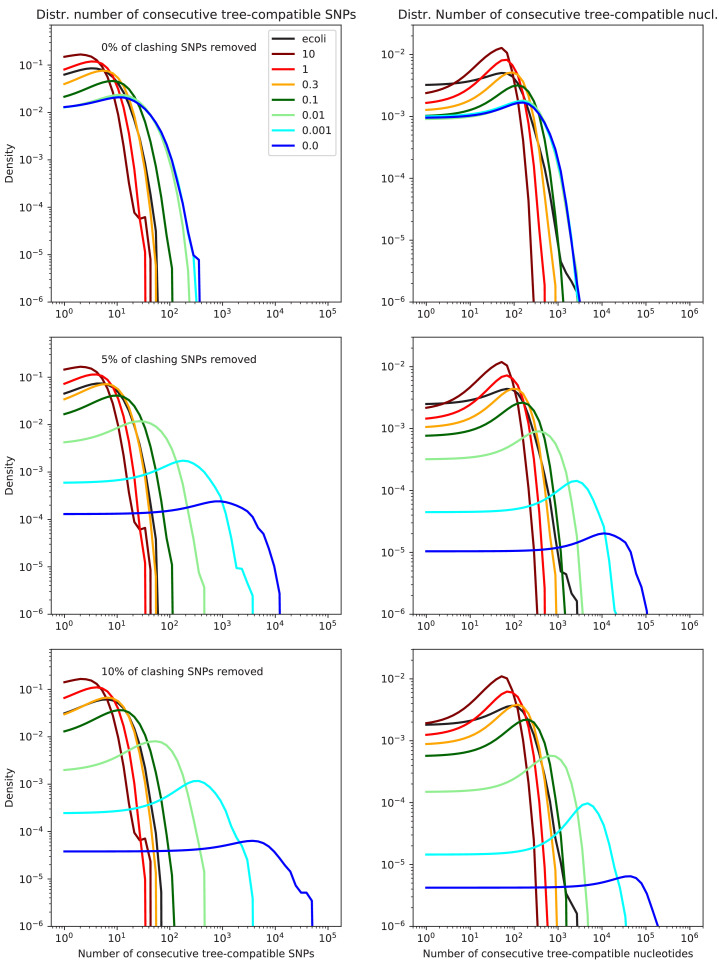
Lengths of tree-compatible segments for the data from the simulations.Probability distributions of the length of tree-compatible segments along the alignments of the E. coli genomes (black line) and the alignments of the sequences from the simulations with ρ/μ=0 (dark blue), ρ/μ=0.001 (light blue), ρ/μ=0.01 (light green), ρ/μ=0.1 (dark green), ρ/μ=0.3 (orange), ρ/μ=1 (red), and ρ/μ=10 (dark red). The left panels show the distributions of the number of consecutive SNP columns and the right panels the distributions of the number of consecutive nucleotides. The top row corresponds to the full alignments, and the middle and bottoms row to the alignments from which 5% and 10% of potentially homoplasic positions have been removed, respectively. All axes are shown on logarithmic scales.